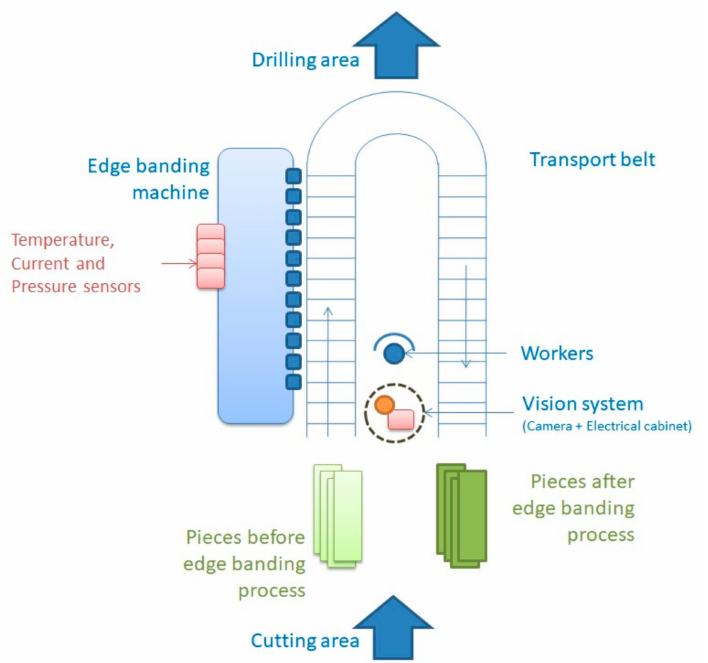
Figure 4. Preliminary placement of the devices around the edge banding machine. The metallic cabinet is used to store the electrical panel with all the connected devices.